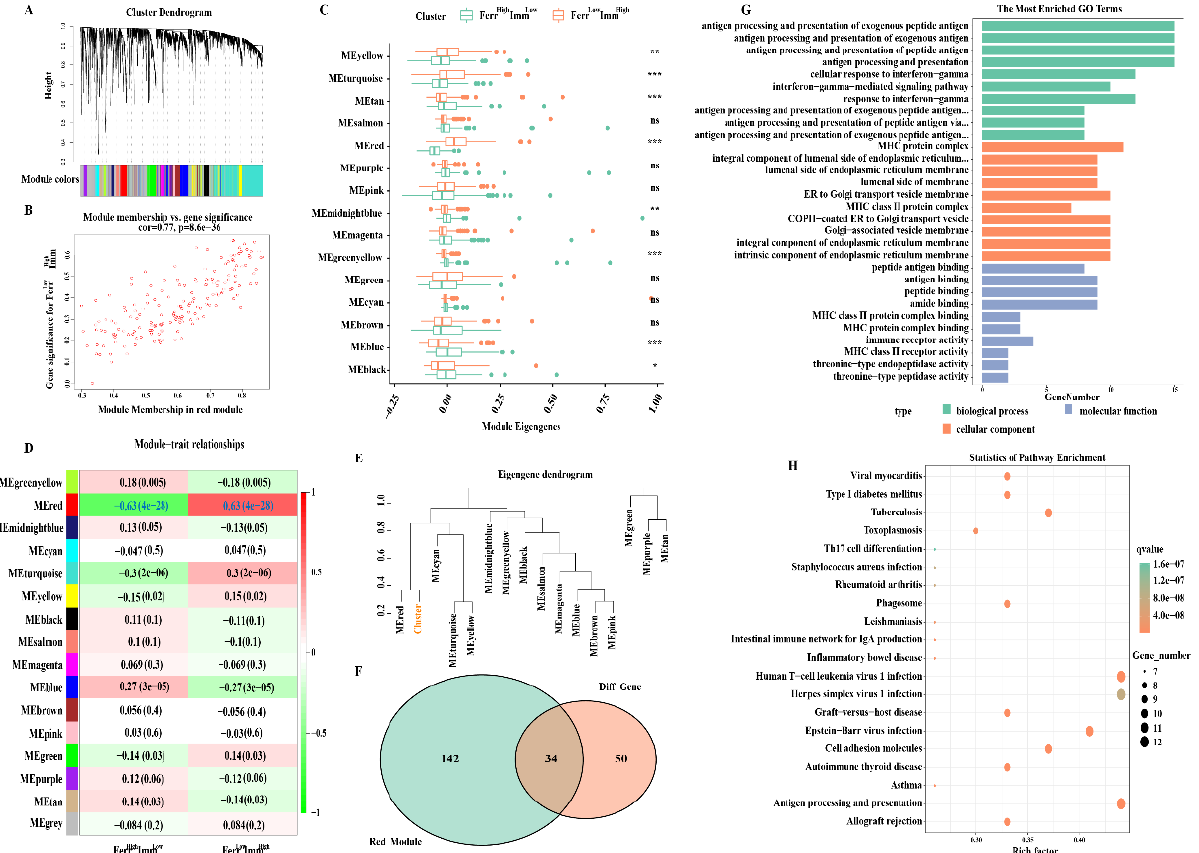
Figure 7. Ferroptosis − immunity related gene screening and functional analysis: ( A ) Gene co − expression network analysis. ( B ) Correlation scatter plot between the red module and the genes in the module. ( C ) Expression of the identified gene modules in the subtypes. ( D ) Diagram of the correlation between the module and Ferr High Imm Low and Ferr Low Imm High group. Each cell contains the corresponding correlation and p value. ( E ) Dendrogram of gene modules shows that the red module is highly correlated with the subtypes. ( F ) The Venn diagram shows the number of crucial genes among the DEGs and red module. ( G , H ) Gene ontology terms enriched and KEGG pathway analysis. ns, nonsignificant; * p < 0.05; ** p < 0.01; *** p < 0.001.